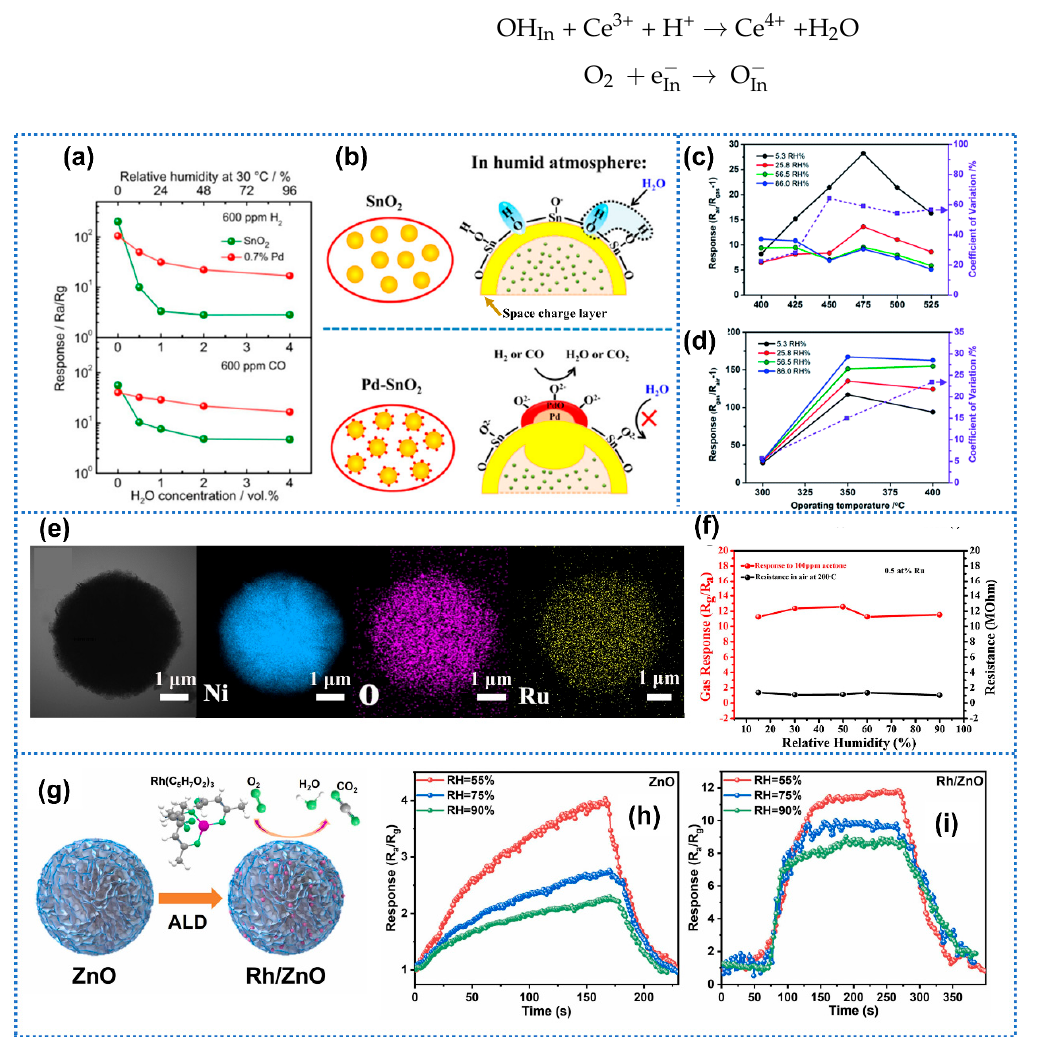
Figure 3. ( a ) Sensor response to 600 ppm H 2 and CO for SnO 2 and 0.7% Pd − SnO 2 in different